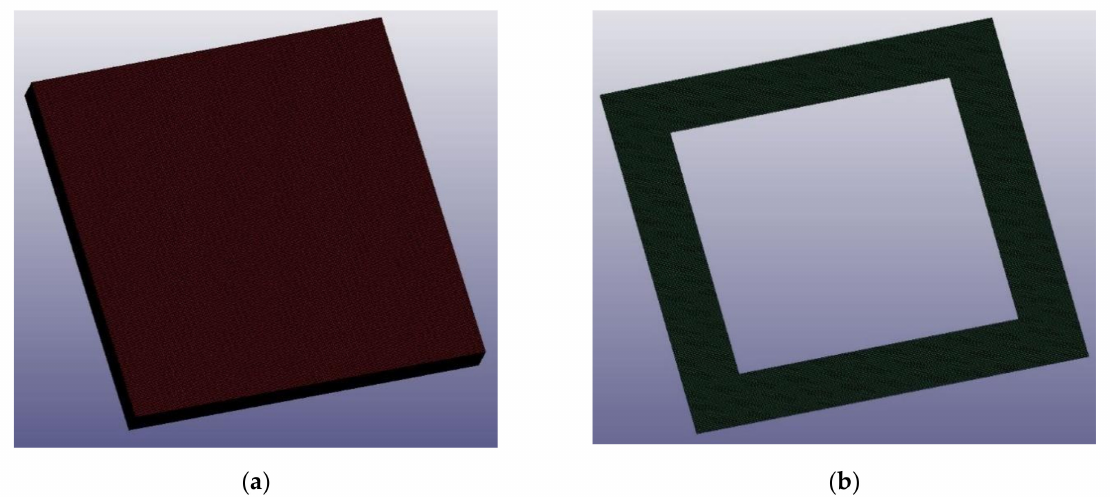
Figure 1. CAD models: ( a ) The mesh of the concrete slab: 700 × 700 × 6 mm; ( b ) The supporting frame: outer dimensions 700 × 700 mm, inner dimensions 400 × 400 mm.